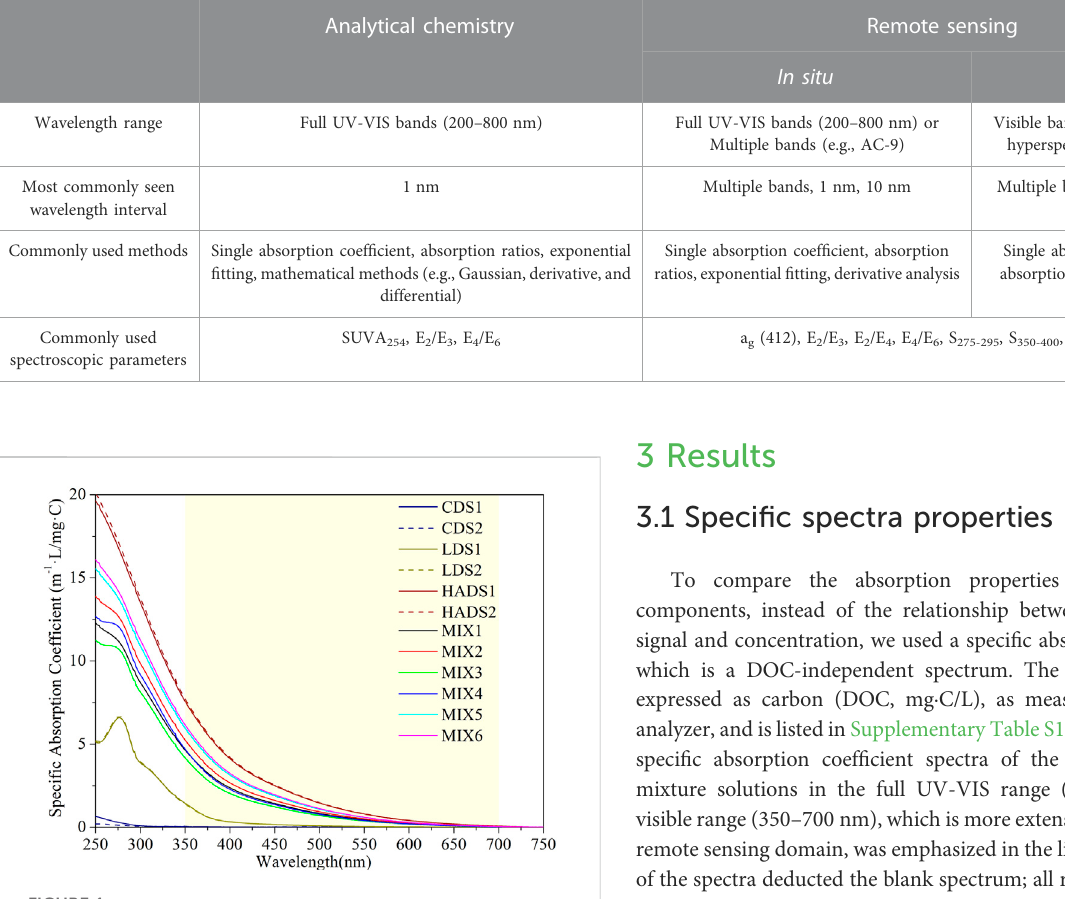
FIGURE 1 Speci fi c absorption coef fi cient spectra for sample solutions (duplicate in dash line) in range 250 – 750 nm. The light yellow area emphasized the visible range from 350 to 700